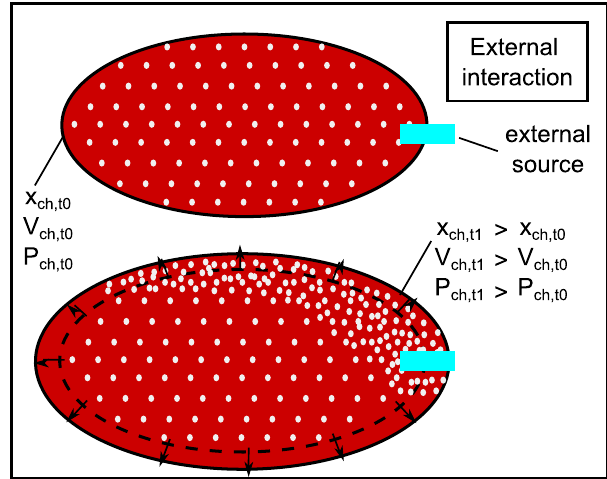
Fig. 6 Schematic representation of volatile accumulation due to interaction with an external source. As opposed to what illustrated in Fig. 1, we consider that, at time t 0 , the magma chamber comes in contact with an external source of volatiles (such as carbonate rocks), which will start to release volatiles within the chamber as exsolved bubbles. With time, due to the injection of these new bubbles into the magmatic system (which will accumulate close to the external source and towards the top of the chamber), the total volatile content within magma chamber will increase (x ch,t1 > x ch,t0 ). Furthermore, this addition of new mass into the system will also produce an increase in magma chamber pressure (P ch,t1 > P ch,t0 ) and a consequent increase in chamber volume (V ch,t1 > V ch,t0